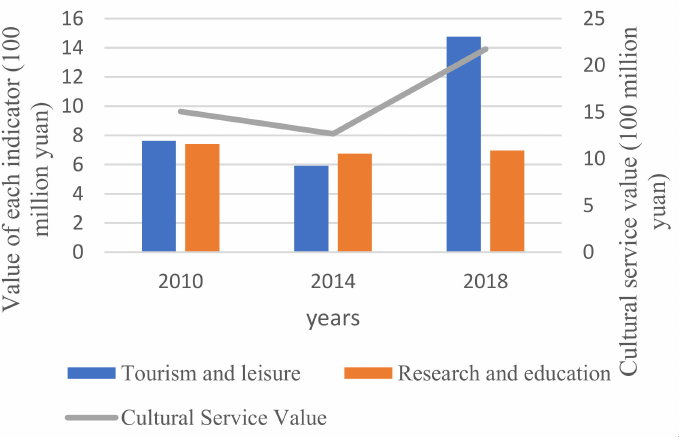
Figure 7. Cultural Service